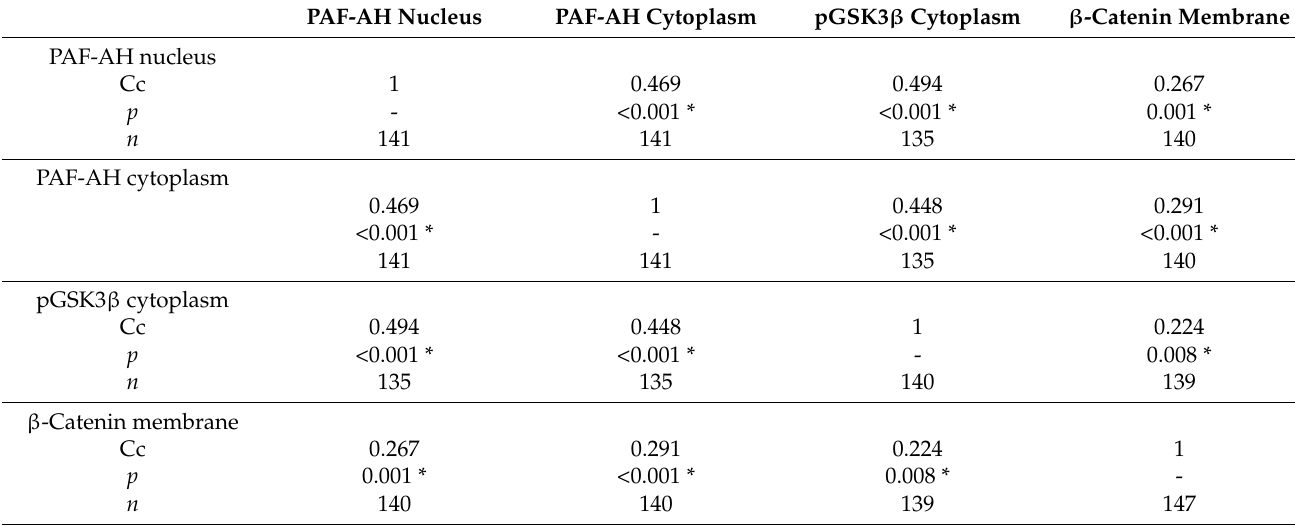
Table 4. Correlations between PAF-AH and Wnt signaling proteins pGSK3 β and β -catenin.